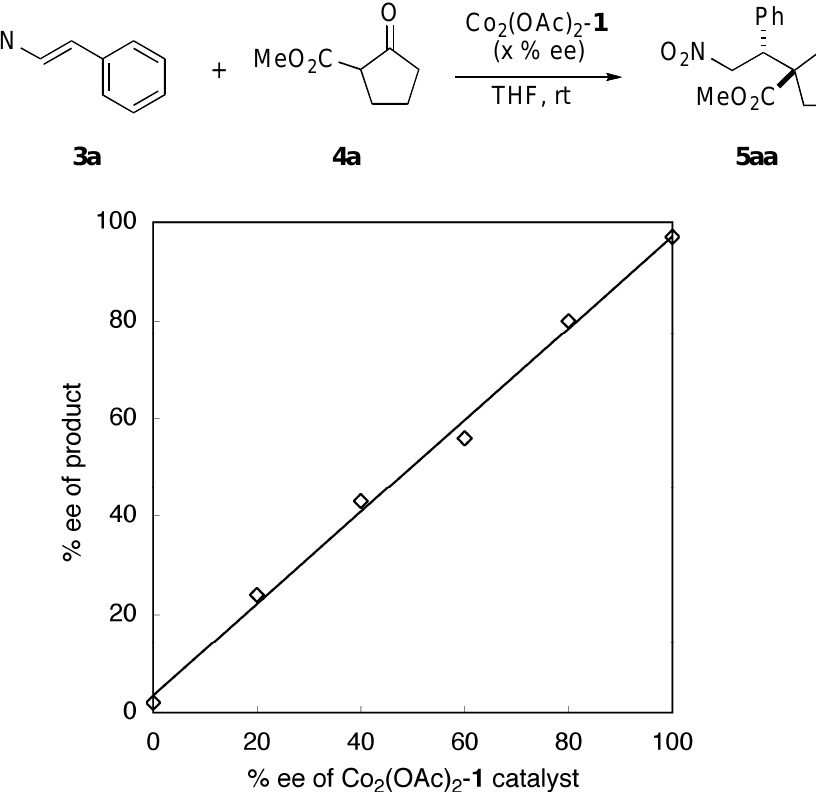
Figure 3. Linear relationship between% ee of bimetallic Co product 5aa